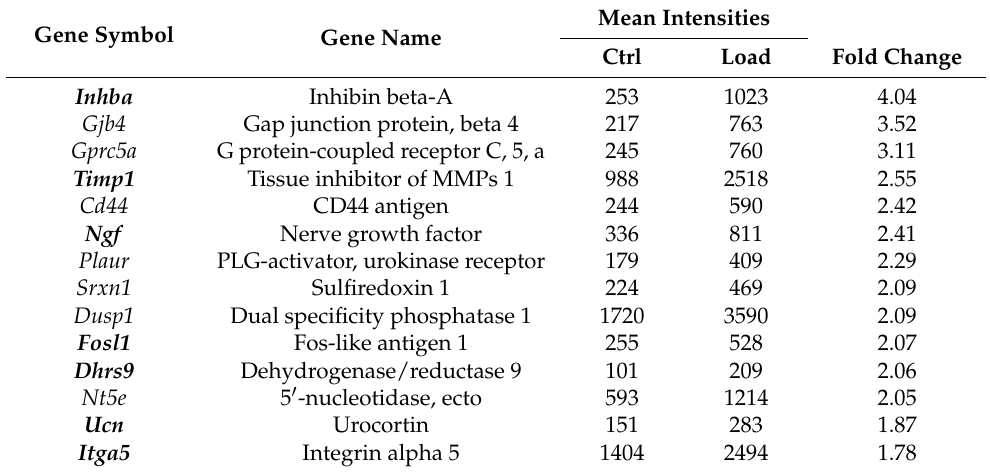
Figure 3. Mechanical loading of engineered cartilage. ( A ) Schematic representation of the dynamic unconfined compression protocol imitating the impact of 3 h of normal walking in 10-min intervals. During a 3-h loading episode, dynamic compression at 1 Hz with an amplitude of 25% was superimposed on 10% static-offset. Nine loading intervals were separated by 10-min breaks. ( B ) Engineered cartilage (“c”) attached to a bone replacement phase (“b”) was fixed in the loading device. A mobile stamp (“s”) applied 10% static compression (upper picture) that was superimposed by 25% dynamic compression (lower picture). ( C ) After 14 days of differentiation culture, Ext1 gt/gt and WT cartilage tissue was exposed to the 3-h loading episode (+) or kept unloaded (-). Specimens were snap frozen immediately at termination of loading. Western blot analysis of active pERK1/2 and total ERK1/2 as well as active pP38 and total P38 levels was performed with β -actin used as a loading control. Representative blots are shown ( n = 6–9, 5–6 donors). Table 1. Mean microarray expression levels of mRNAs differentially expressed in loaded and non- loaded Ext1 gt/gt samples according to Significance Analysis of